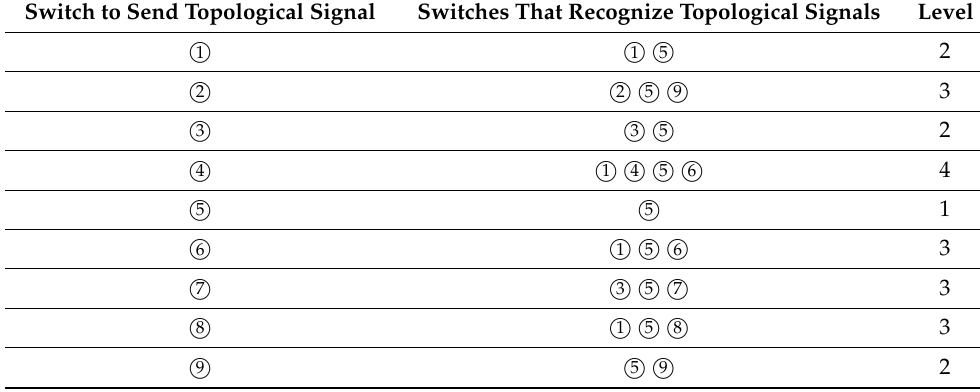
Table 4. Topology Data